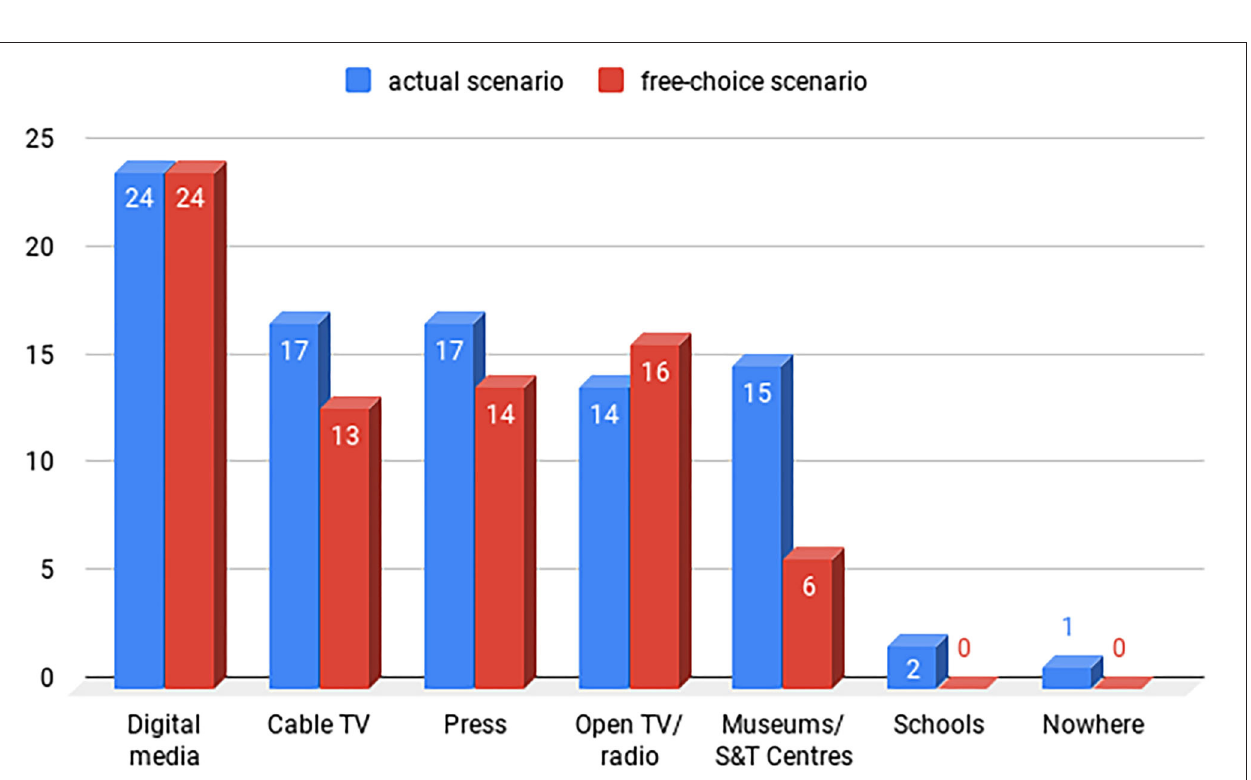
FIGURE 8 | Preferred media/ locations for SC in actual scenario and free-choice scenario.